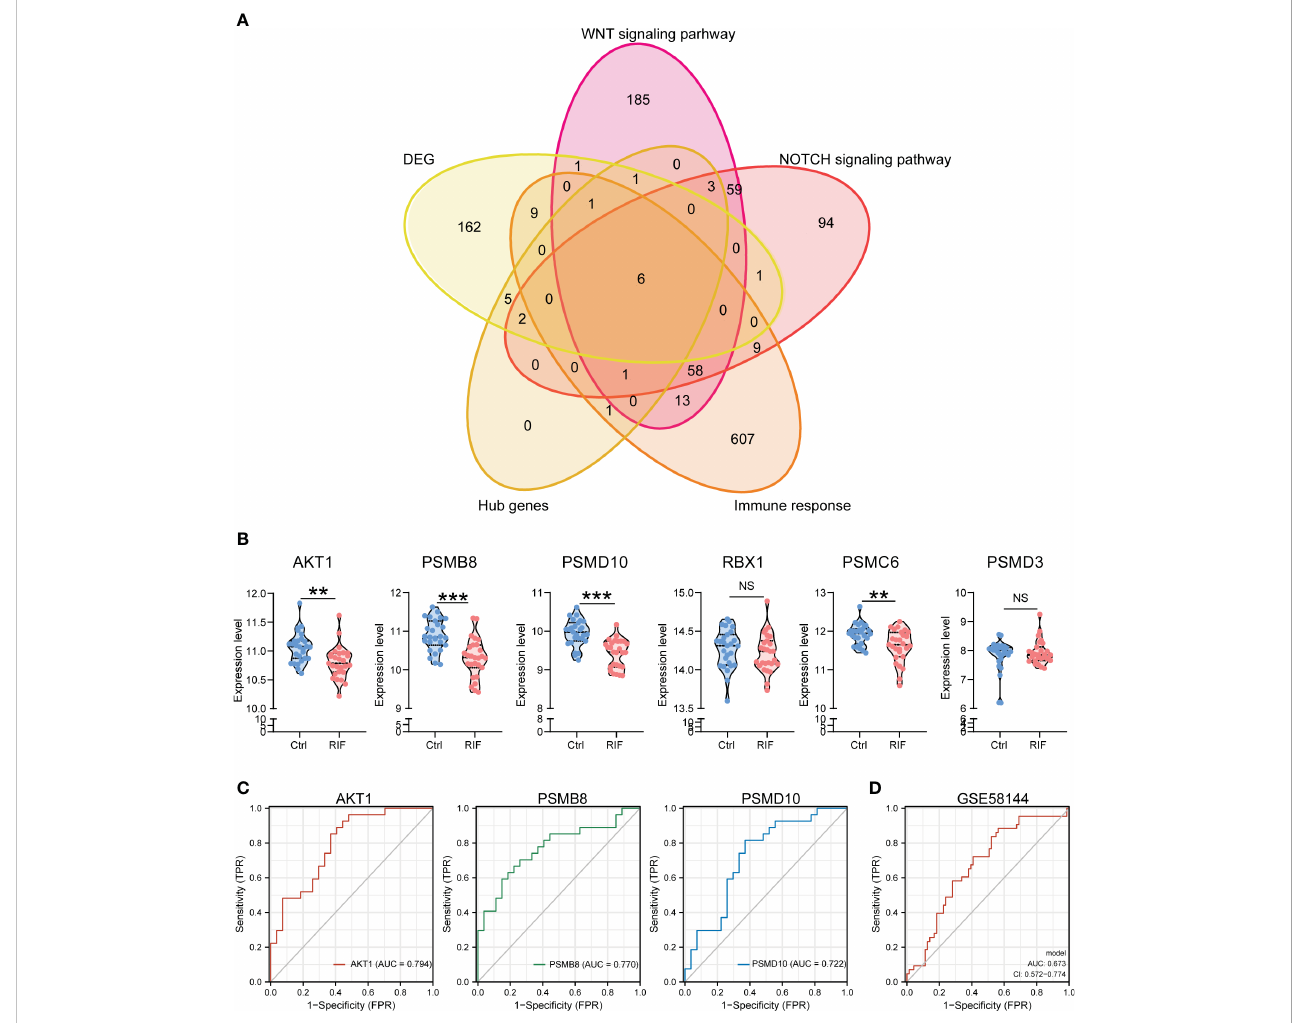
FIGURE 7 Expression Levels and Diagnose Signi fi cance of Hub Genes. (A) Venn diagram of common hub genes identi fi ed among DEGs, Wnt/ b -catenin signaling pathway, NOTCH signaling pathway, immune response, and hub genes. (B) The expression levels of 6 hub genes in GSE103465, and GSE111974 datasets. (C) The GSE103465, and GSE111974 datasets were used to train the diagnostic effectiveness of the biomarkers for RIF by ROC analysis. (D) The GSE58144 dataset was used to validate the diagnostic effectiveness of the biomarkers (AKT1, PSMB8, and PSMD10) for RIF by ROC analysis. Data are presented as the median and the interquartile range. Statistical signi fi cance (Kruskal – Wallis test with Dunn ’ s multiple-comparison test): NS, no signi fi cant difference, **p < 0.01, ***p <